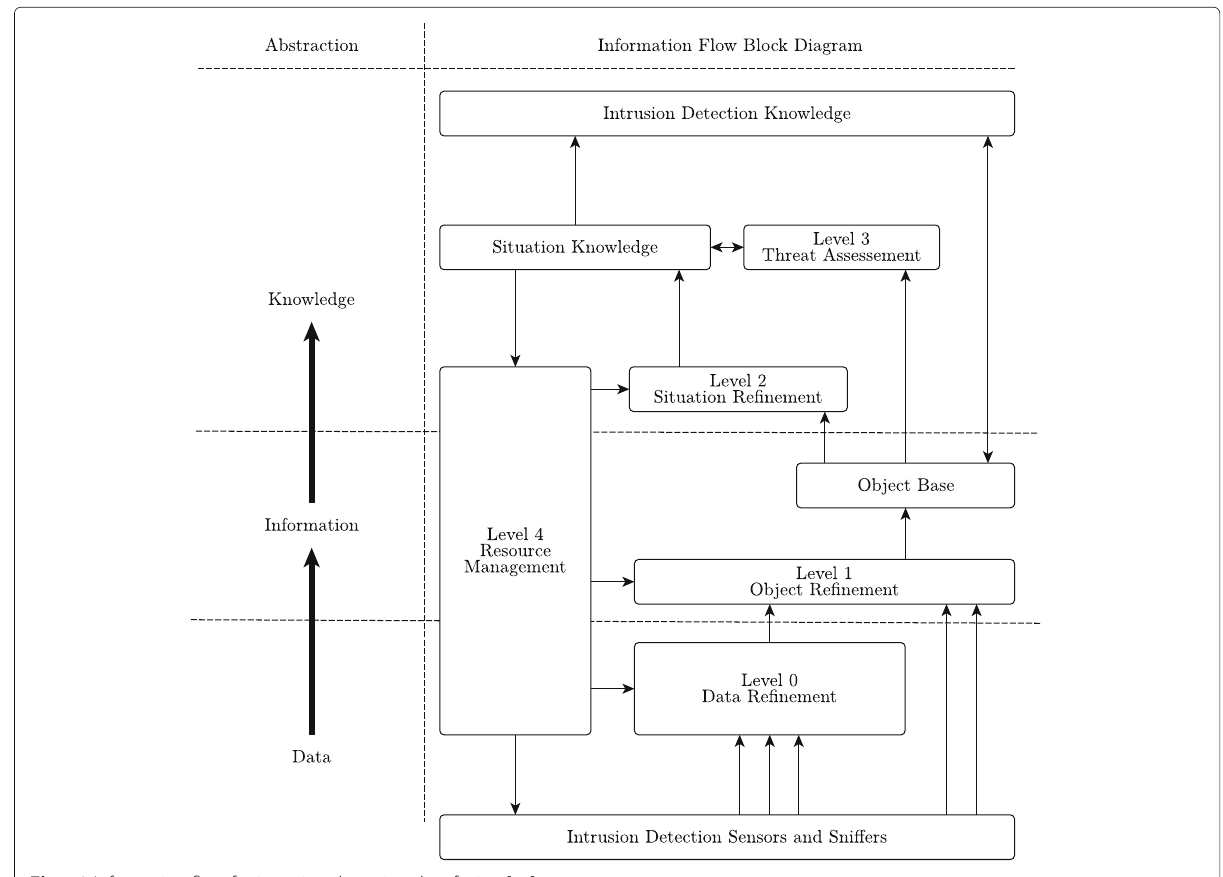
Fig. 12 Information flow for intrusion detection data fusion